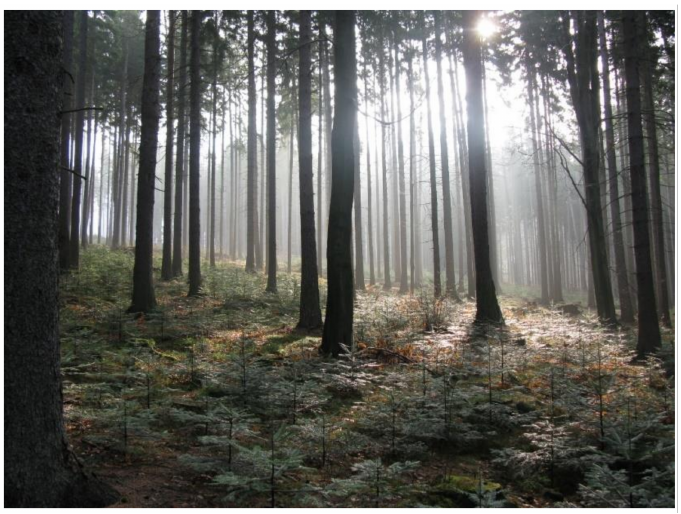
Figure 3. Naturally regenerated tree seedlings in the understory of an even-aged stand (photo: Z.